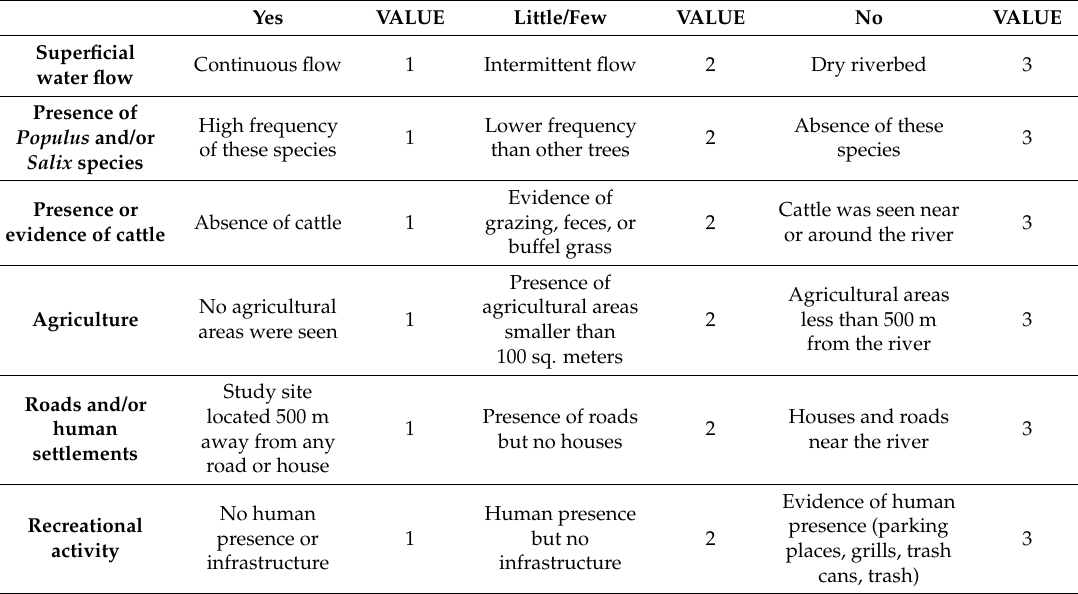
Table 1. Criteria used to determine the